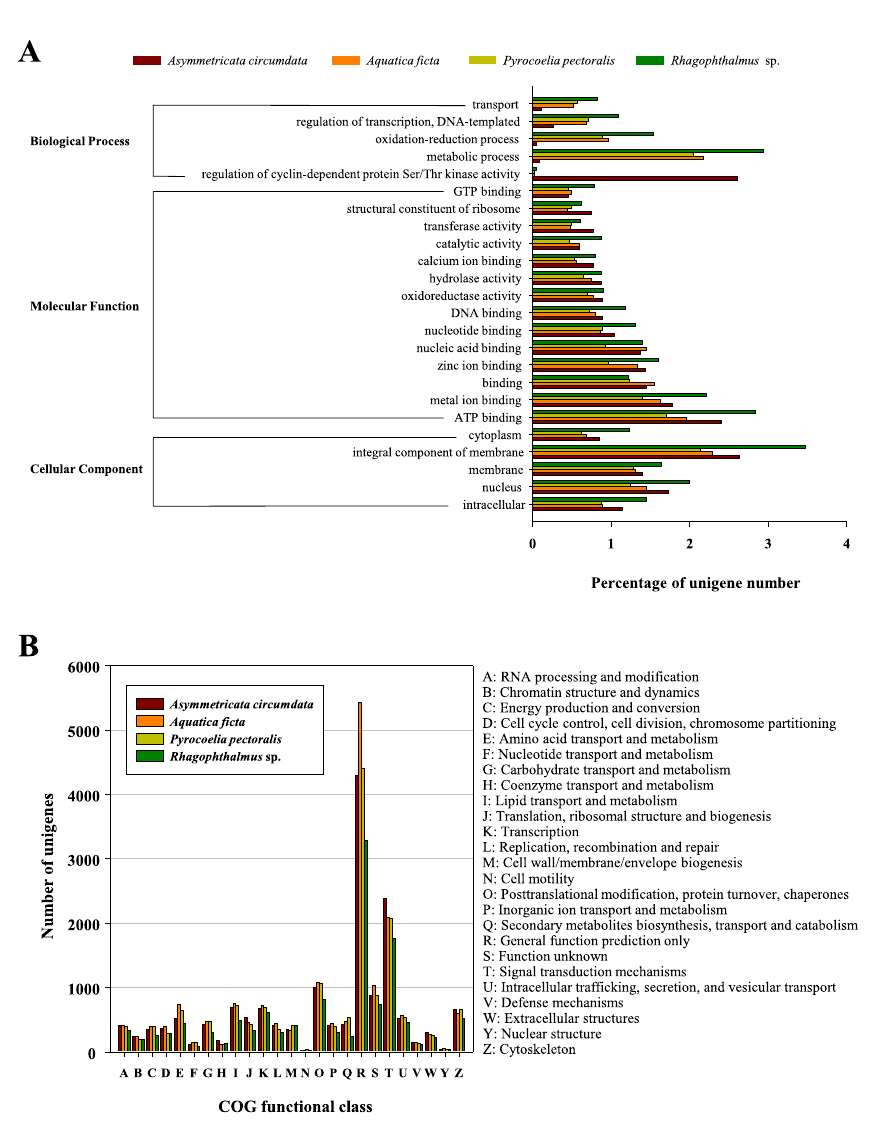
Figure 1. Functional classification of unigenes derived from the four transcriptomes based on the GO (Gene Ontology) annotation ( A ) and the COG (Cluster of Orthologous Groups) annotation ( B